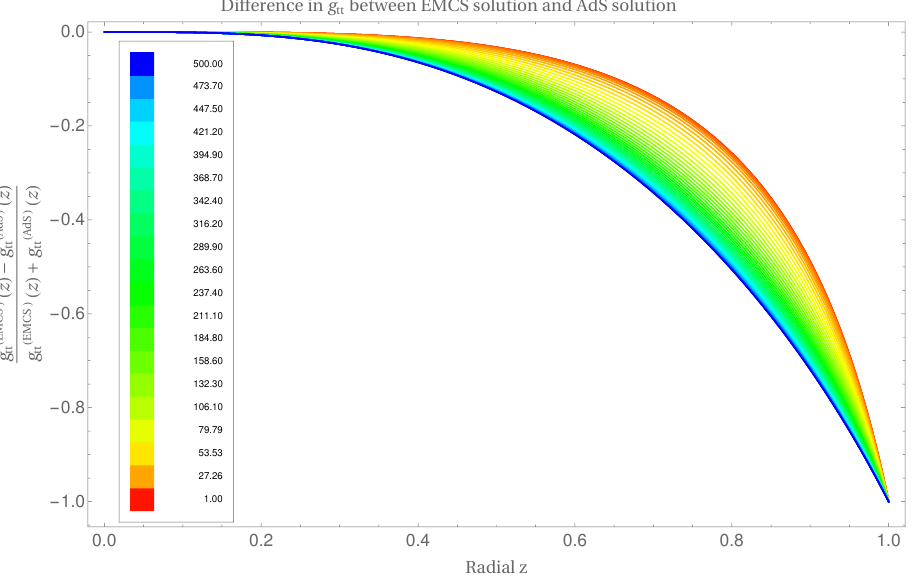
Figure 3 . We display the difference between the blackening factor U ( z ) for full solutions to Einstein-Maxwell-Chern-Simons theory and the empty AdS solutions. The inset legend displays the coloring for different values of B/T 2 . The difference between these spacetimes can be seen to be very large deep in the bulk as we move towards B/T 2 (cid:29) 1 . Note that the same plot but replacing U AdS with the Reissner-Nordström value U RN shows that U EMCS ≈ U RN at the horizon for small B/T 2 . In other words, charged magnetic black branes have a similar blackening factor as charged black branes at the horizon. They become more distinct as B/T 2